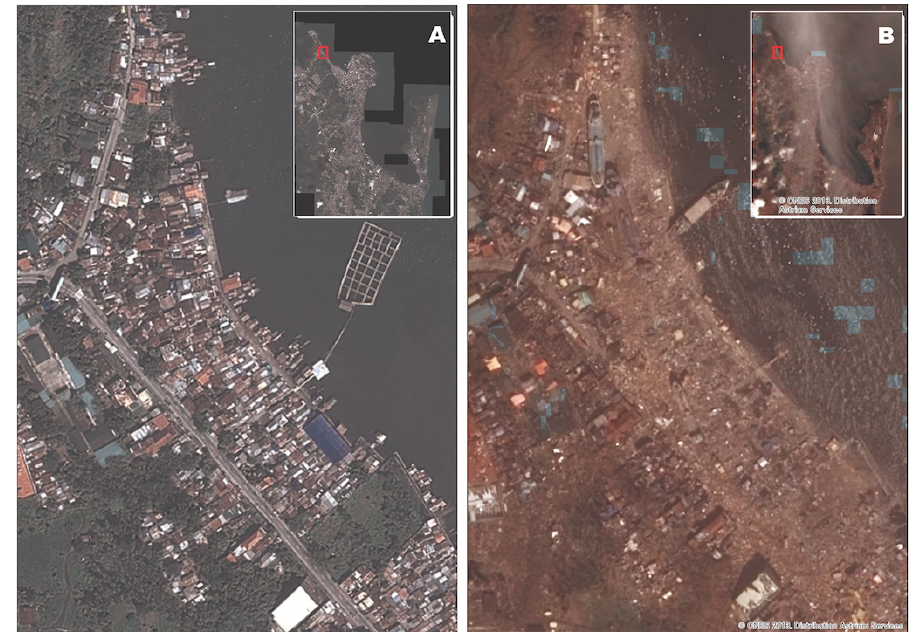
Figure 2. (a) Pre-event satellite image obtained from a mosaic of Google Earth snapshots (imagery date: 23 February 2012). (b) Post-event Pléiades/Astrium service satellite image. In addition, a Digital Globe image in Google Earth was used for areas in the northern part of the study area (imagery date: 13 November